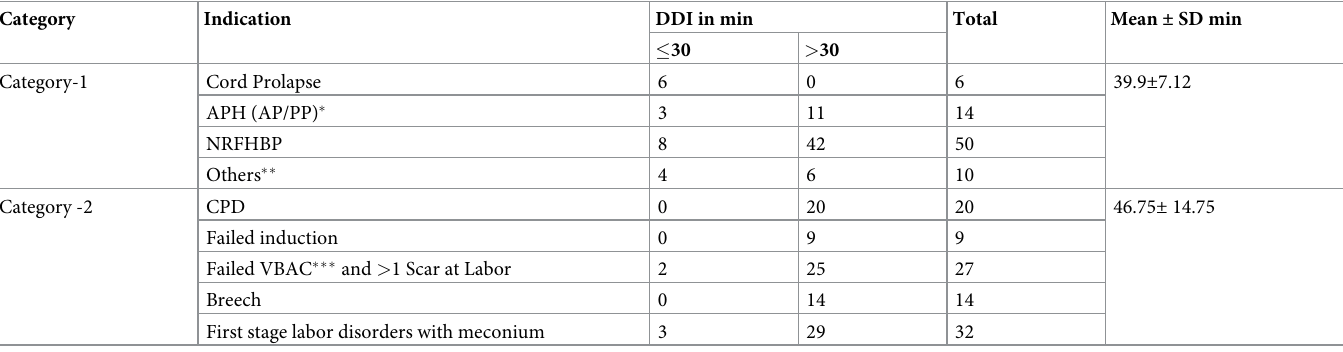
Table 3. Indication for emergency cesarean section, in Bahir Dar City Public Hospitals, Ethiopia, 2020 (n = 182). Category